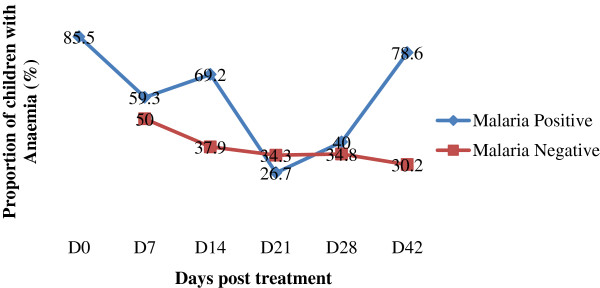
Proportion of children with anaemia during follow up.